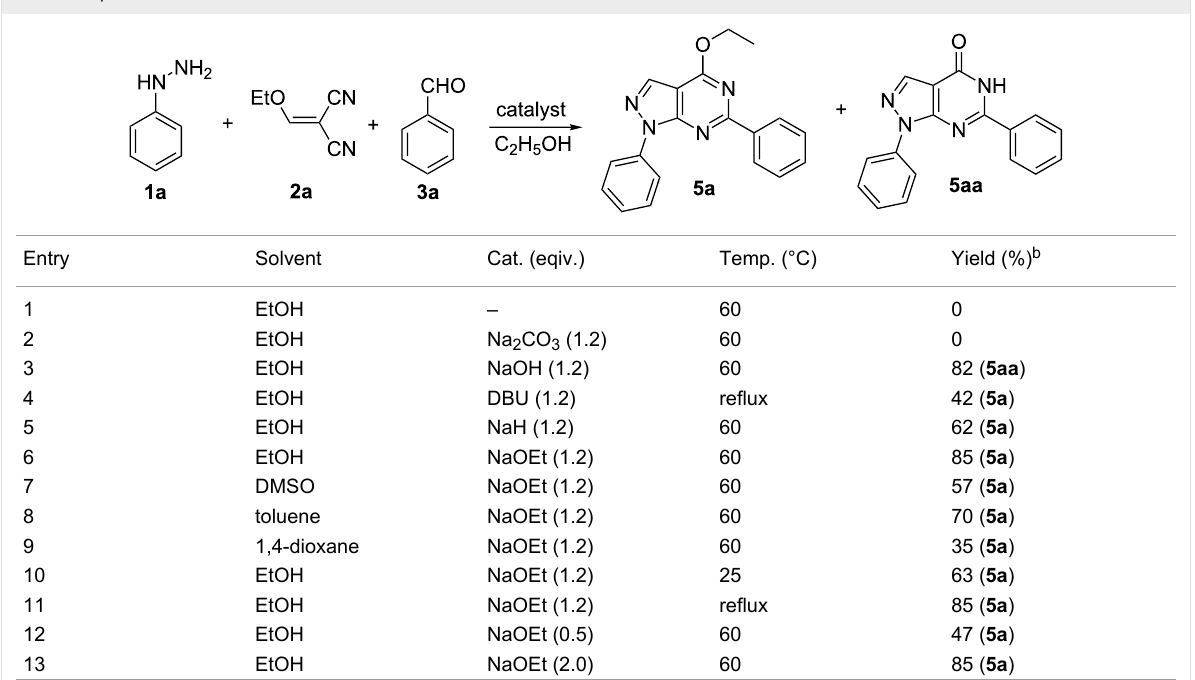
Table 1: Optimization of the reaction conditions a